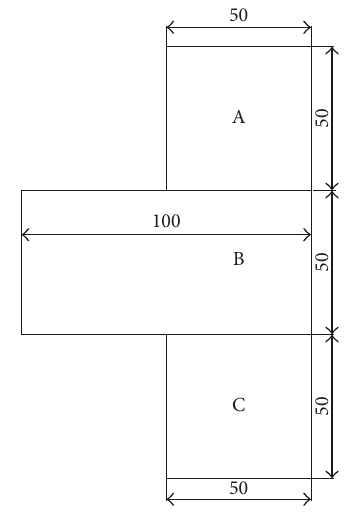
Figure 2: Sample arrangement. Note: the length unit is